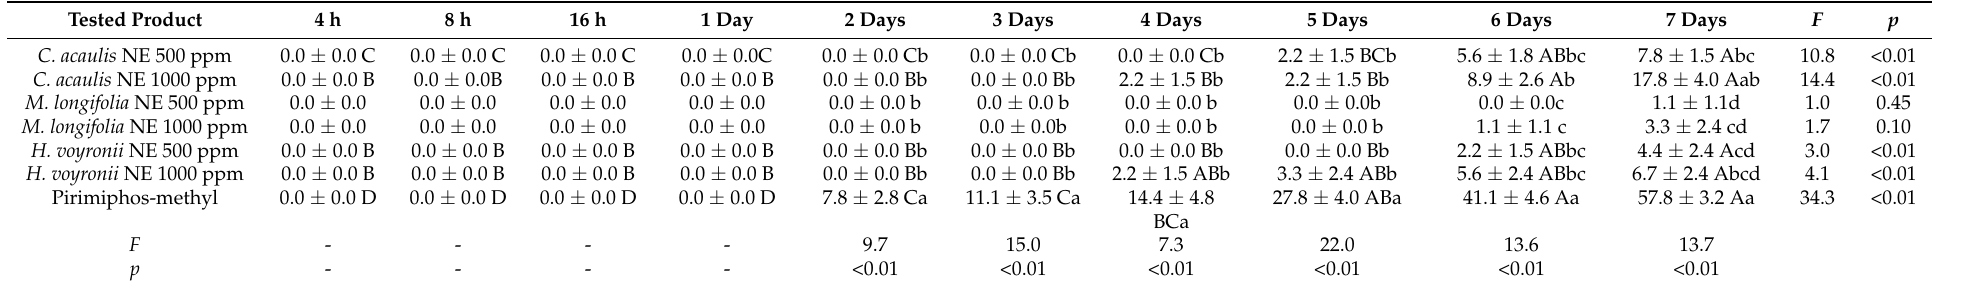
Within each row, means followed by the same uppercase letter are not significantly different (DF = 9, 89; Tukey’s HSD test at p = 0.05). Within each column, means followed by the same lowercase letter are not significantly different (DF = 6, 62; Tukey’s HSD test at p = 0.05). Where no letters exist, no significant differences were recorded. Where dashes exist, no analysis was